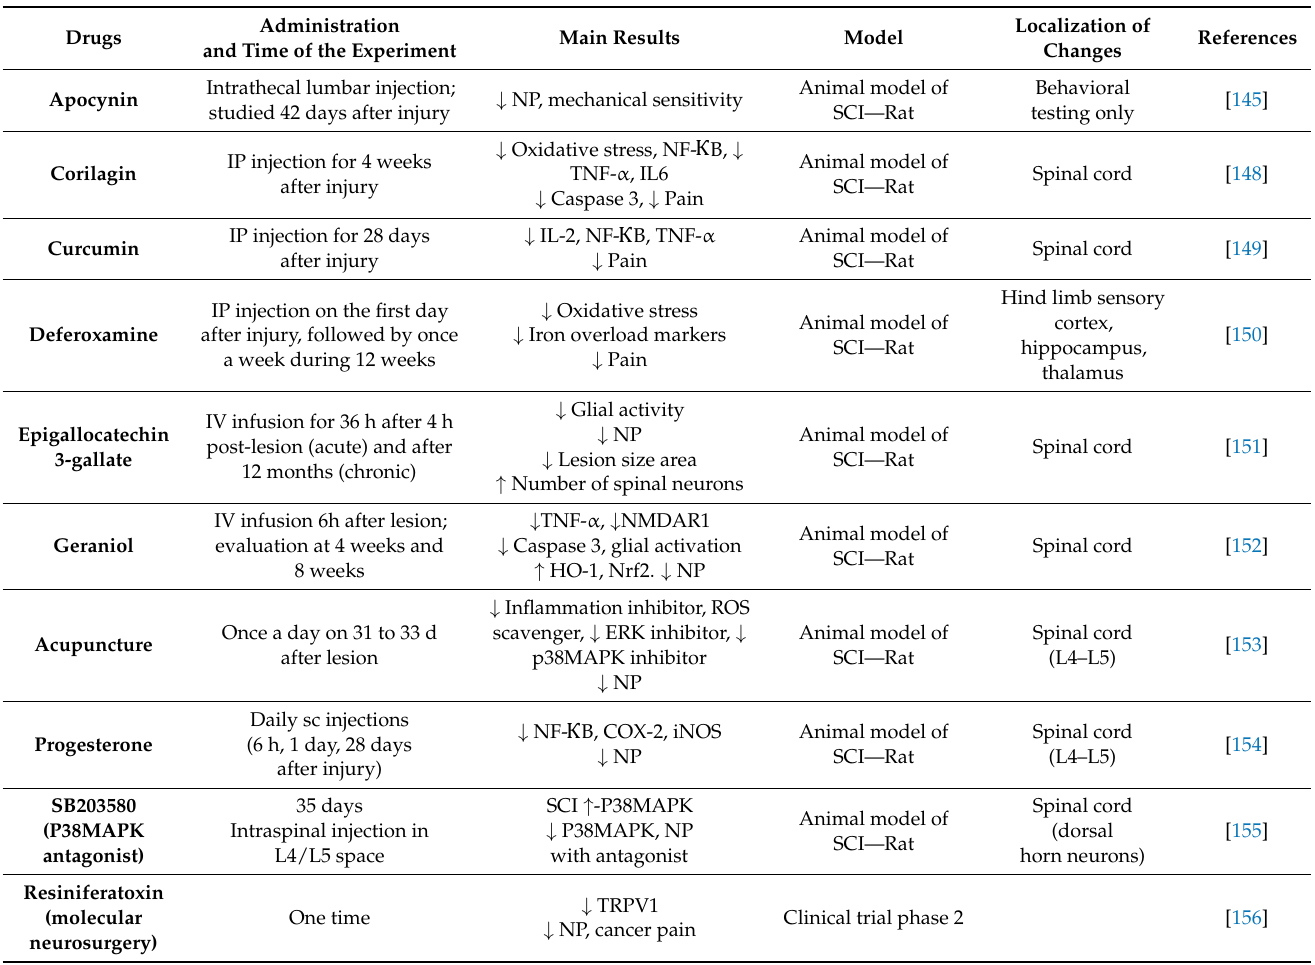
Table 1. Some preclinical/clinical studies with drugs/compounds involved in apoptosis that could potentially treat